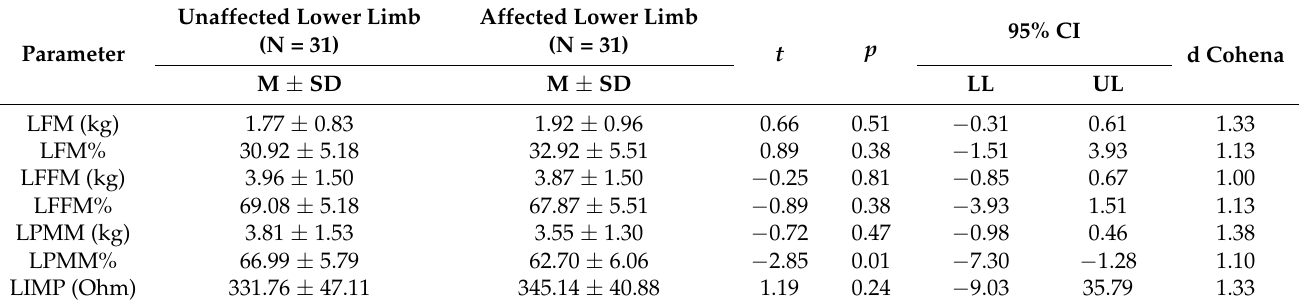
Table 4. Descriptive characteristics of segmental body composition of the affected and unaffected lower limbs of children in the tested group with statistical analysis (Student’s t -test).